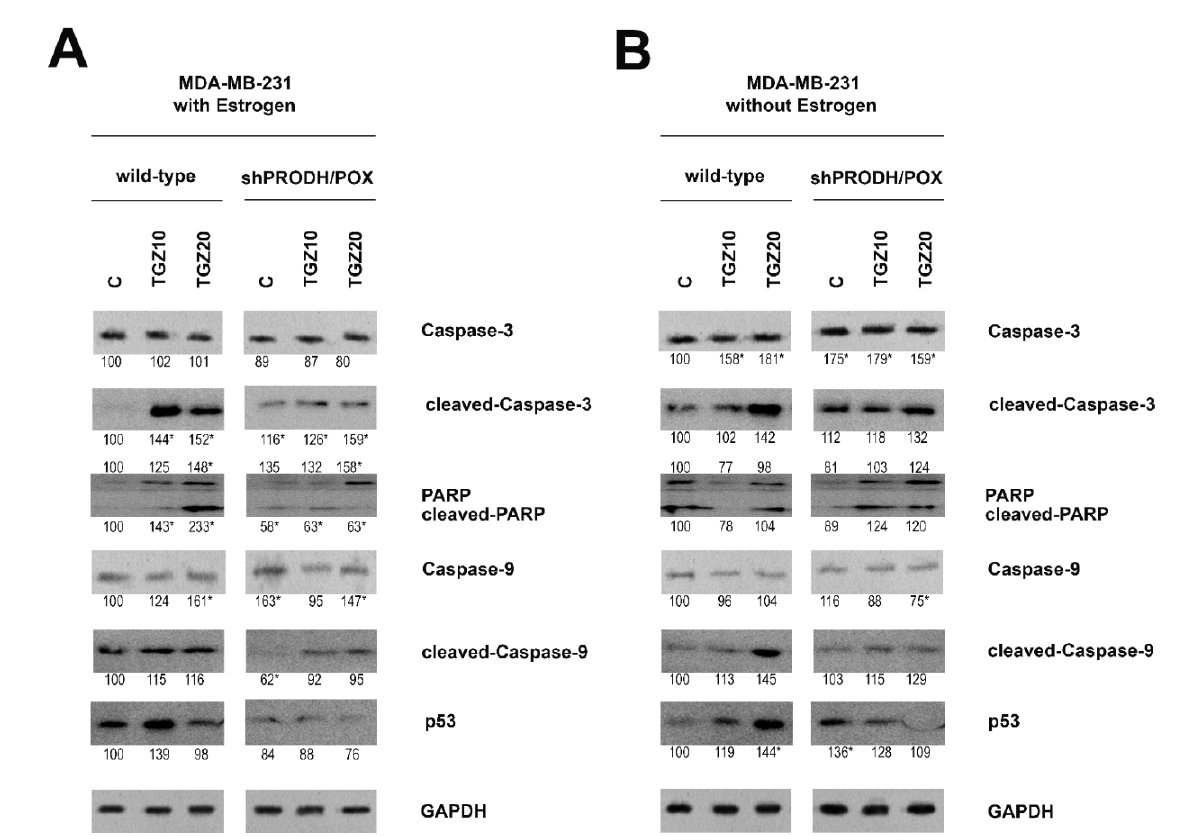
Figure 4. Western blot for cleaved caspase-3, PARP, caspase-9 and p53 in wild type and PRODH/POX-silenced (shPRODH/POX) MDA-MB-231 cells treated with troglitazone (TGZ) for 24 h in the presence ( A ) and absence ( B ) of estradiol. GAPDH expression was used as a loading control. Representative blot images were shown (the mean value of densitometric analysis of protein bands presented below each blot; * p < 0.01). Supplementary Materials contain statistical analysis of the evaluated proteins (Supplementary Material, Supplementary Figures S14–S19).